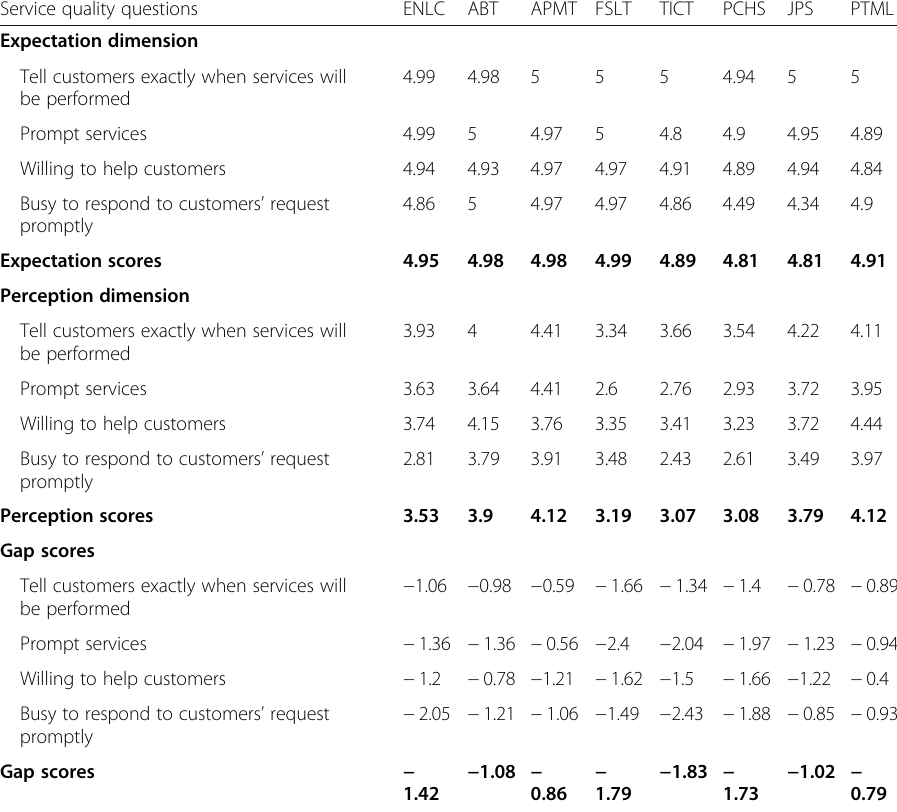
Table 6 Service quality expectation and perception average scores for responsiveness Service quality